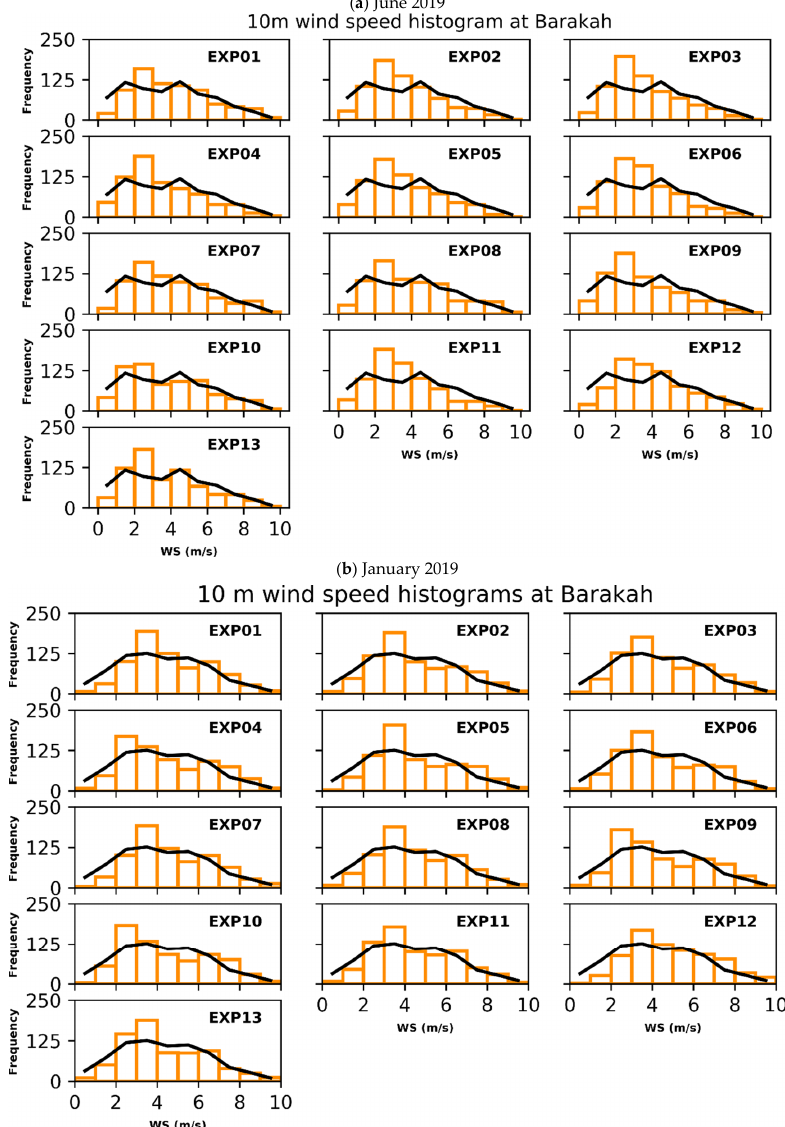
Figure 11. Histograms of simulated 10 m wind speed at Barakah for June ( a ) and January ( b ). The black line denotes the observed wind speed histogram. The orange lines depict the simulated histograms.